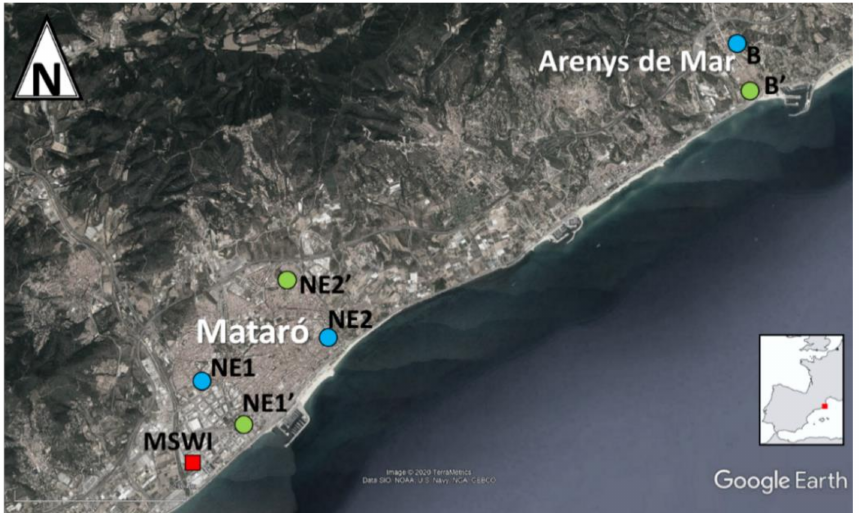
Figure 1. Sampling area. Blue sites indicate locations where samples of both soil and air were collected, while green sites indicate points where only soil was